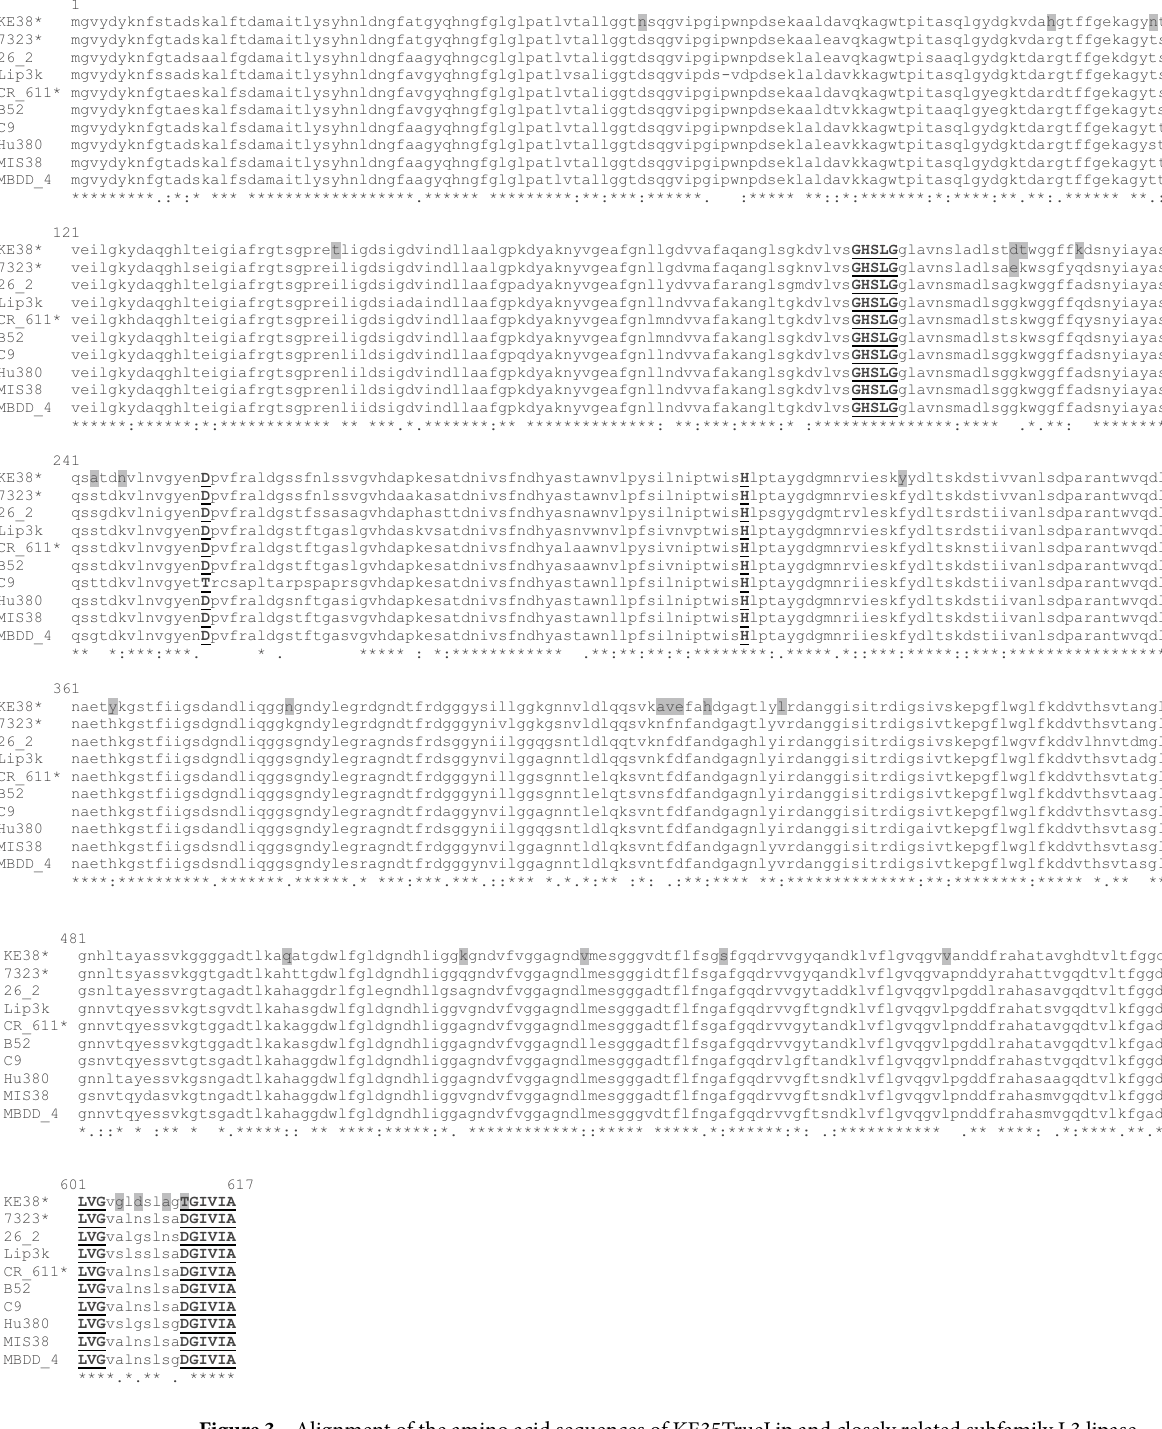
and the expression of the recombinant lipase respectively. Antibiotics for the E. coli transformants were added